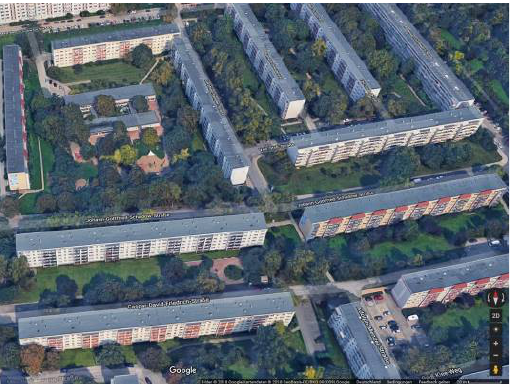
Figure A1. Example of high-rise buildings in Halle Neustadt with public green spaces (Google Maps 2018).